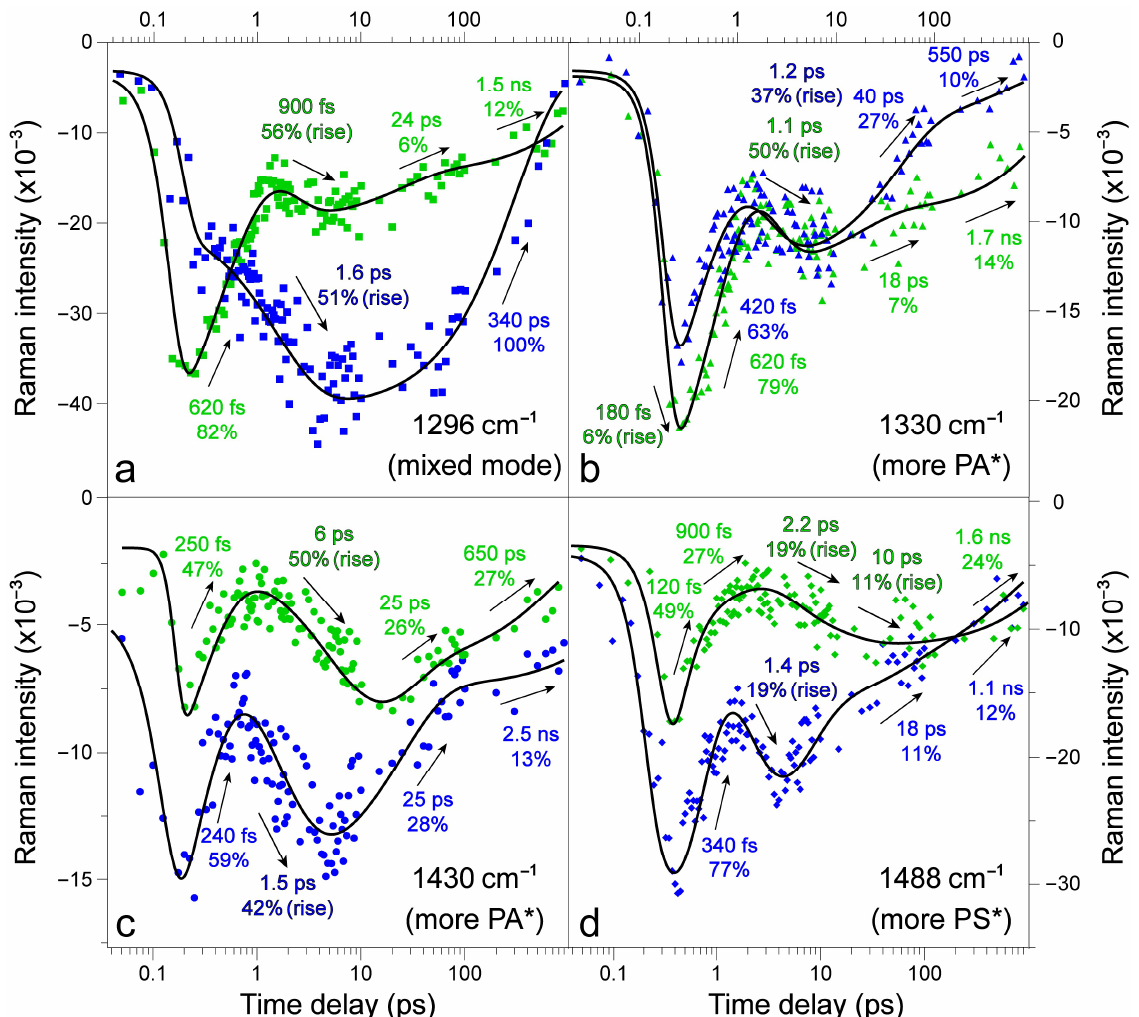
Figure 6. Transient Raman peak intensity dynamics from ES-FSRS of Draconin Red in DCM solvent obtained using a 490 nm actinic pump (A pu ) paired with a 620 nm Raman pump (R pu ) condition (blue) and a 537 nm A pu paired with a 645 nm R pu condition (green). The selective vibrational marker bands for analysis are marked by vertical dashed lines in Figure 4a,b for the ( a ) 1296 cm − 1 mode that arises from a mixed tautomer population, ( b ) 1330 cm − 1 and ( c ) 1430 cm − 1 modes that arise from more PA* species in the excited state, and ( d ) 1488 cm − 1 mode with more PS* contribution. The least-squares fits (black lines) are overlaid with scattered spectral data points in each panel. The retrieved intensity decay time constants and amplitude weights (summed to 100%) are listed by the best fits, with the signal intensity magnitude rise components denoted separately with their amplitude weights scaled to the summation of all the decay components. The stimulated Raman intensity axis is linear while the time delay axis is on the semilogarithmic